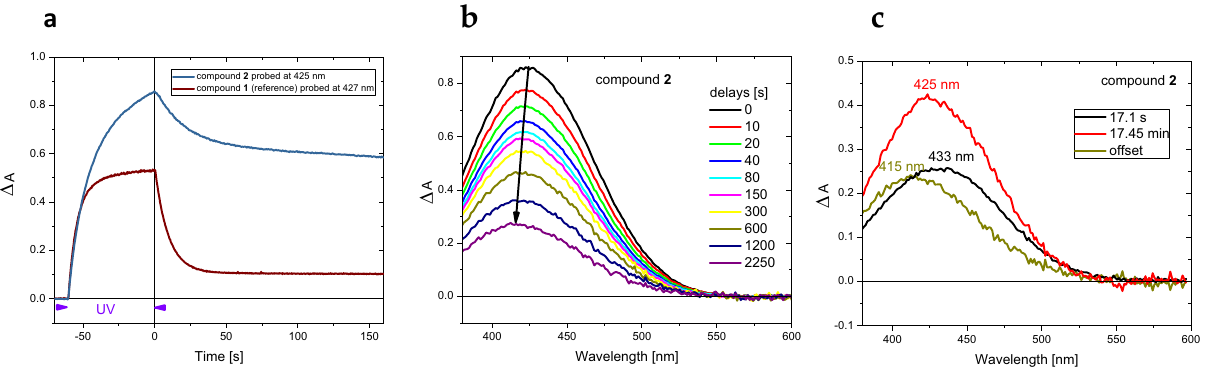
Figure 3. ( a ) Kinetics of the changes in absorption as a result of UV irradiation (4.1 mW/cm 2 ) in the period of 60 s for 2 and the reference 1 in cyclohexane at 21 °C (both solutions prepared with the same absorbance A(365 nm, 1 cm) = 0.24). ( b ) Transient UV–vis absorption spectra for 2 after switching off UV irradiation. ( c ) Decay associated spectra of the TC (17.1 s and 17.5 min) and TT isomers (the offset, long-lived population) obtained by global analysis using a biexponential